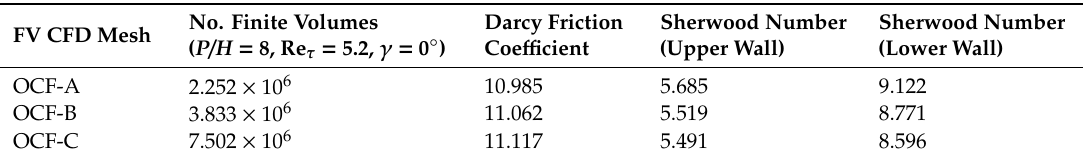
Table 5. Grid dependence results